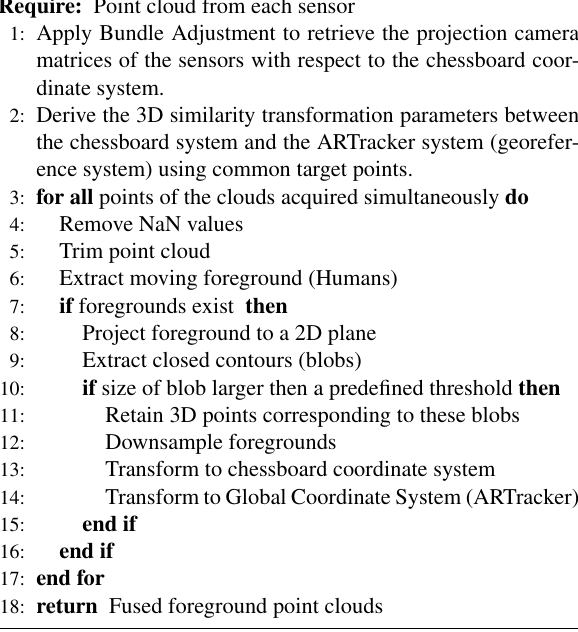
Algorithm 1 Extraction and fusion of foregrounds with synchro- nized